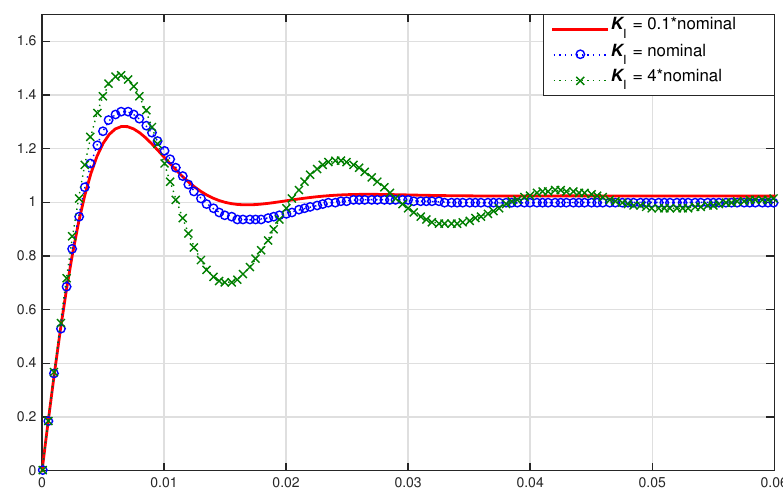
Figure 8. Time domain effects of the integral gain.